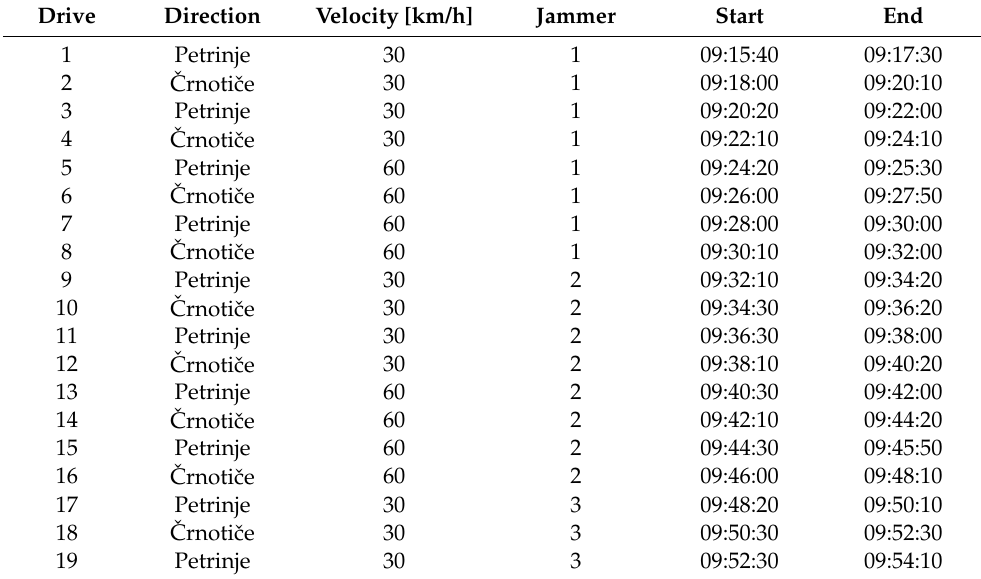
Table 4. Times of drives with different jammers (1, 2, 3); Session 1 of DOY 262. Drive